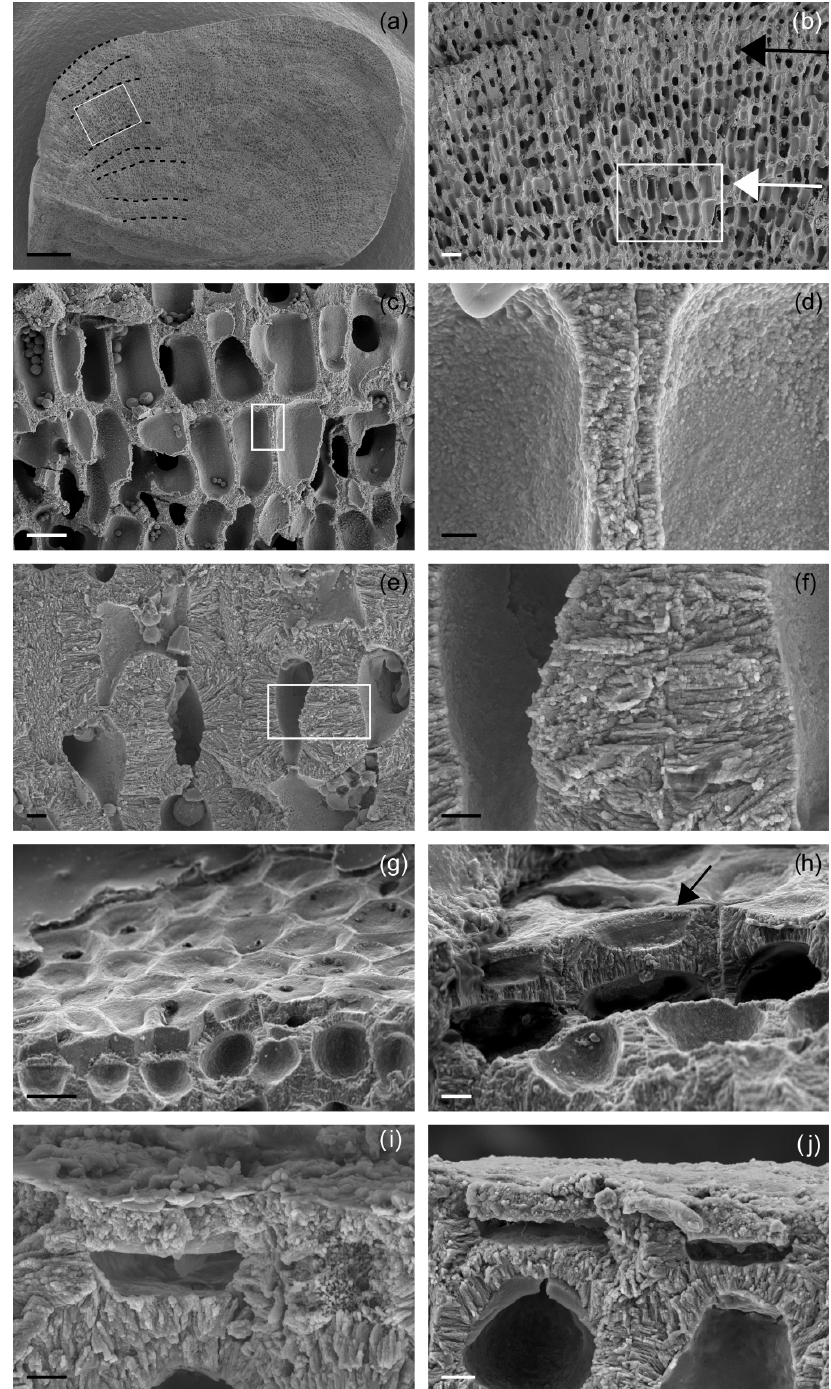
Figure 3. Main features of Lithothamnion corallioides under SEM (Morlaix Bay, France). (a) Longitudinal section of L corallioides with obvious banding (dashed black lines). Scale bar = 100µm. The inset is magnified in (b) ; (b) alternation of thick-walled (black arrow) and thin-walled (white arrow) cells. Scale bar = 20µm. The inset is magnified in (c) ; (c) thin-walled long cells. Scale bar = 10µm. The inset is magnified in (d) ; (d) detail of the thin wall of long cells. Scale bar = 1µm. (e) Thick-walled short cells. Scale bar = 2µm. The inset is magnified in (f) ; (f) detail of the thick wall of short cells. Scale bar = 1µm. (g) Polygonal shape of epithallial cells in surface view. Scale bar = 10µm. (h) Detail of a flared epithallial cell (arrow). Scale bar = 3µm. (i–j) Longitudinal sections of flared epithallial cells with complete mineralization of the cell walls. Scale bar =